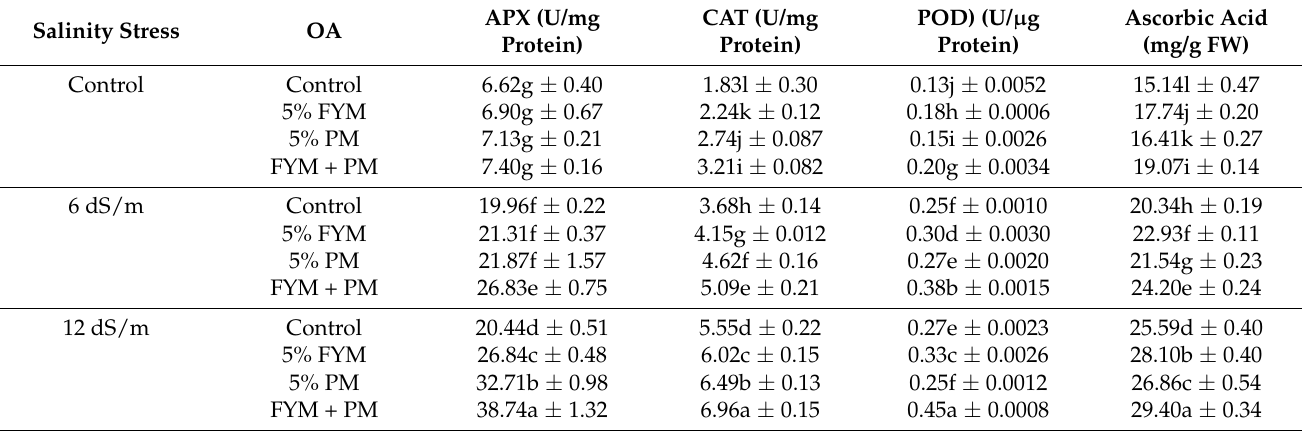
Table 3. Effect of different organic amendments on anti-oxidant activities under diverse salt stress levels. Salinity Stress